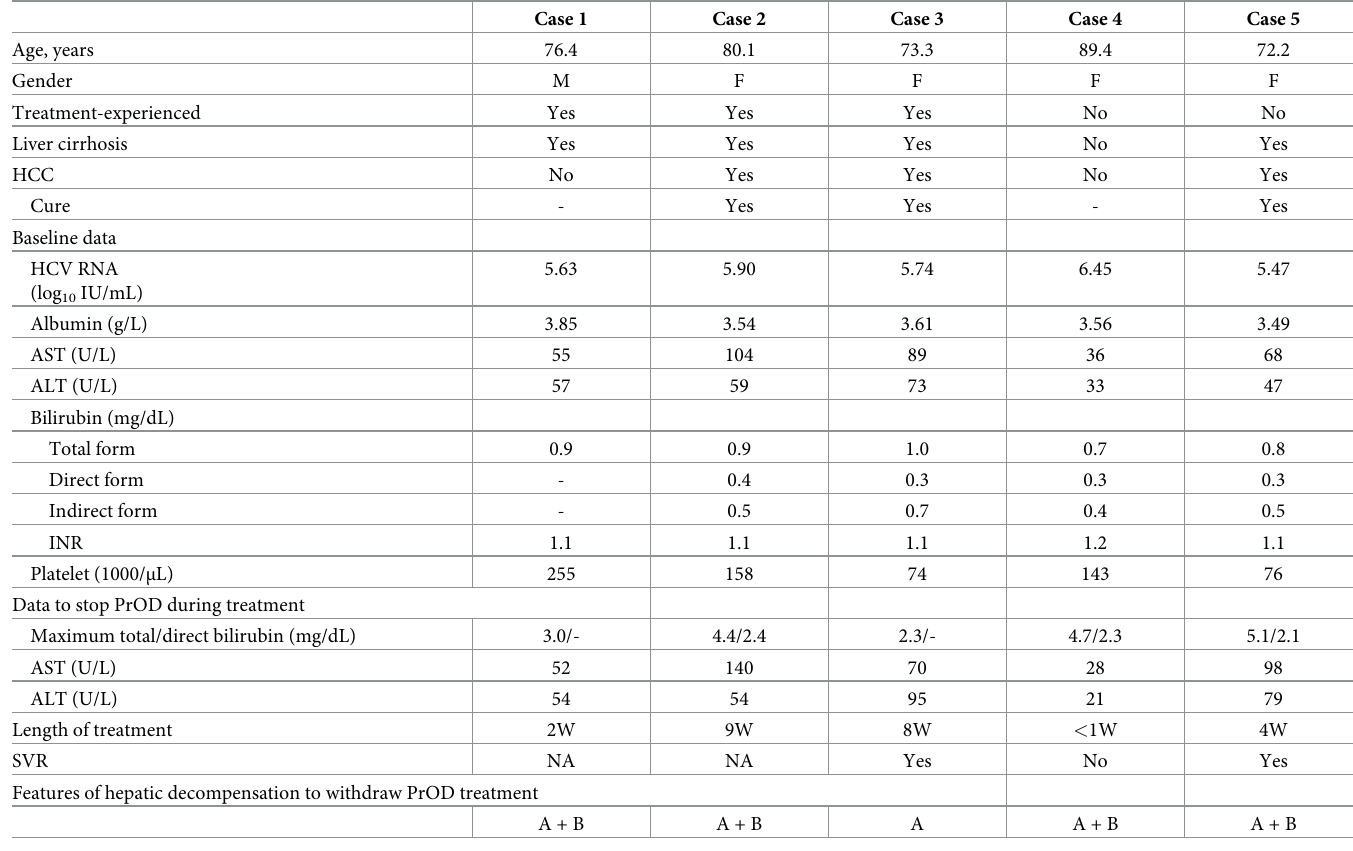
Table 2. Characteristics of 5 patients with on-treatment hepatic decompensation.